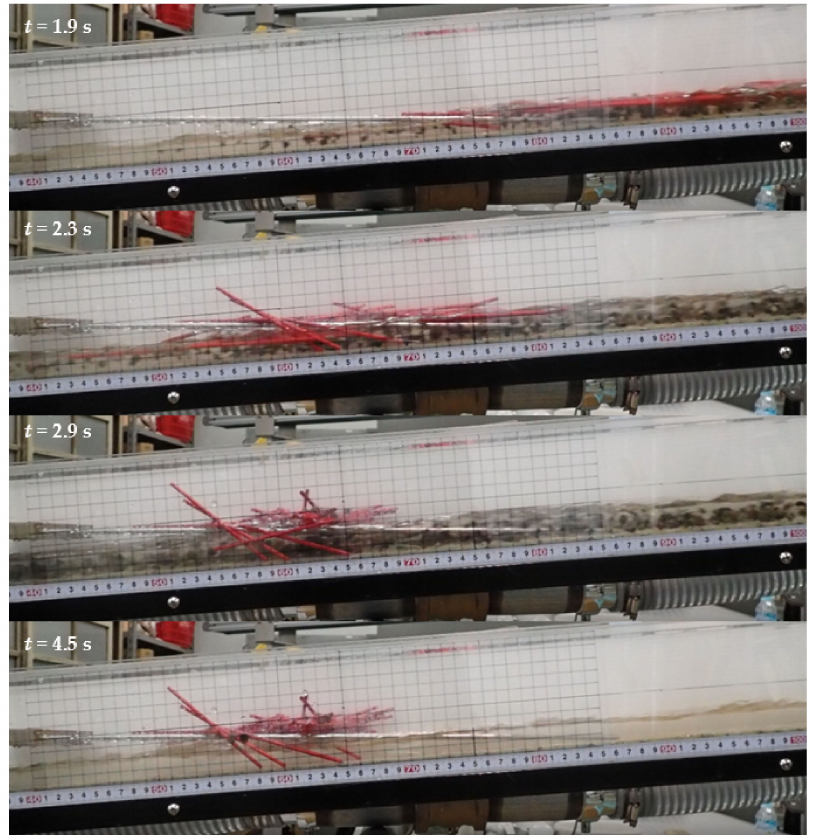
Figure 15. Side view showing sediment passing through the trap and only LW are trapped (volume of sediment = 180 cm 3 , average diameter of sediment = 5